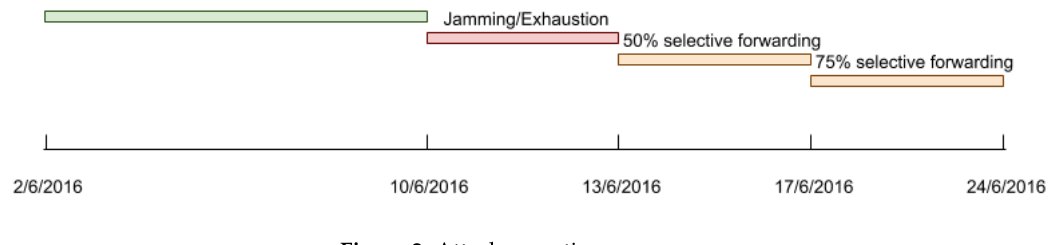
Figure 2. Attack execution